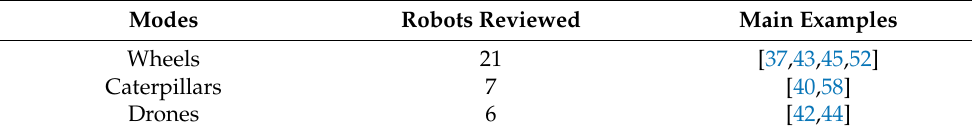
Table 1. Modes of locomotion used by agriculture robots.